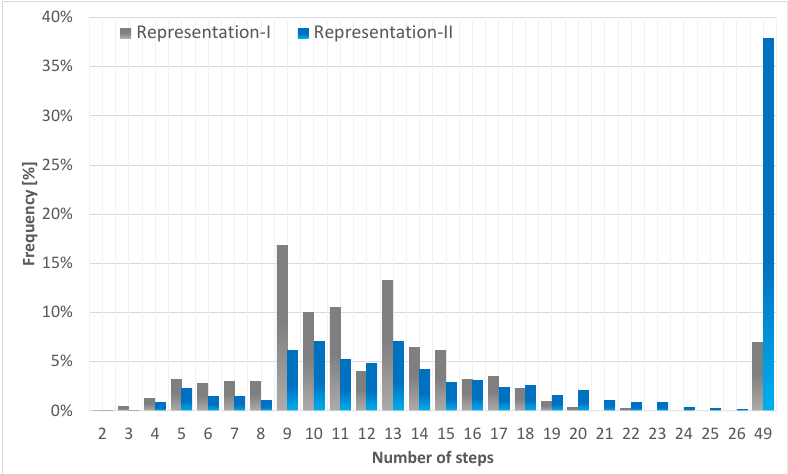
Figure 10. Comparison of the different solutions for both